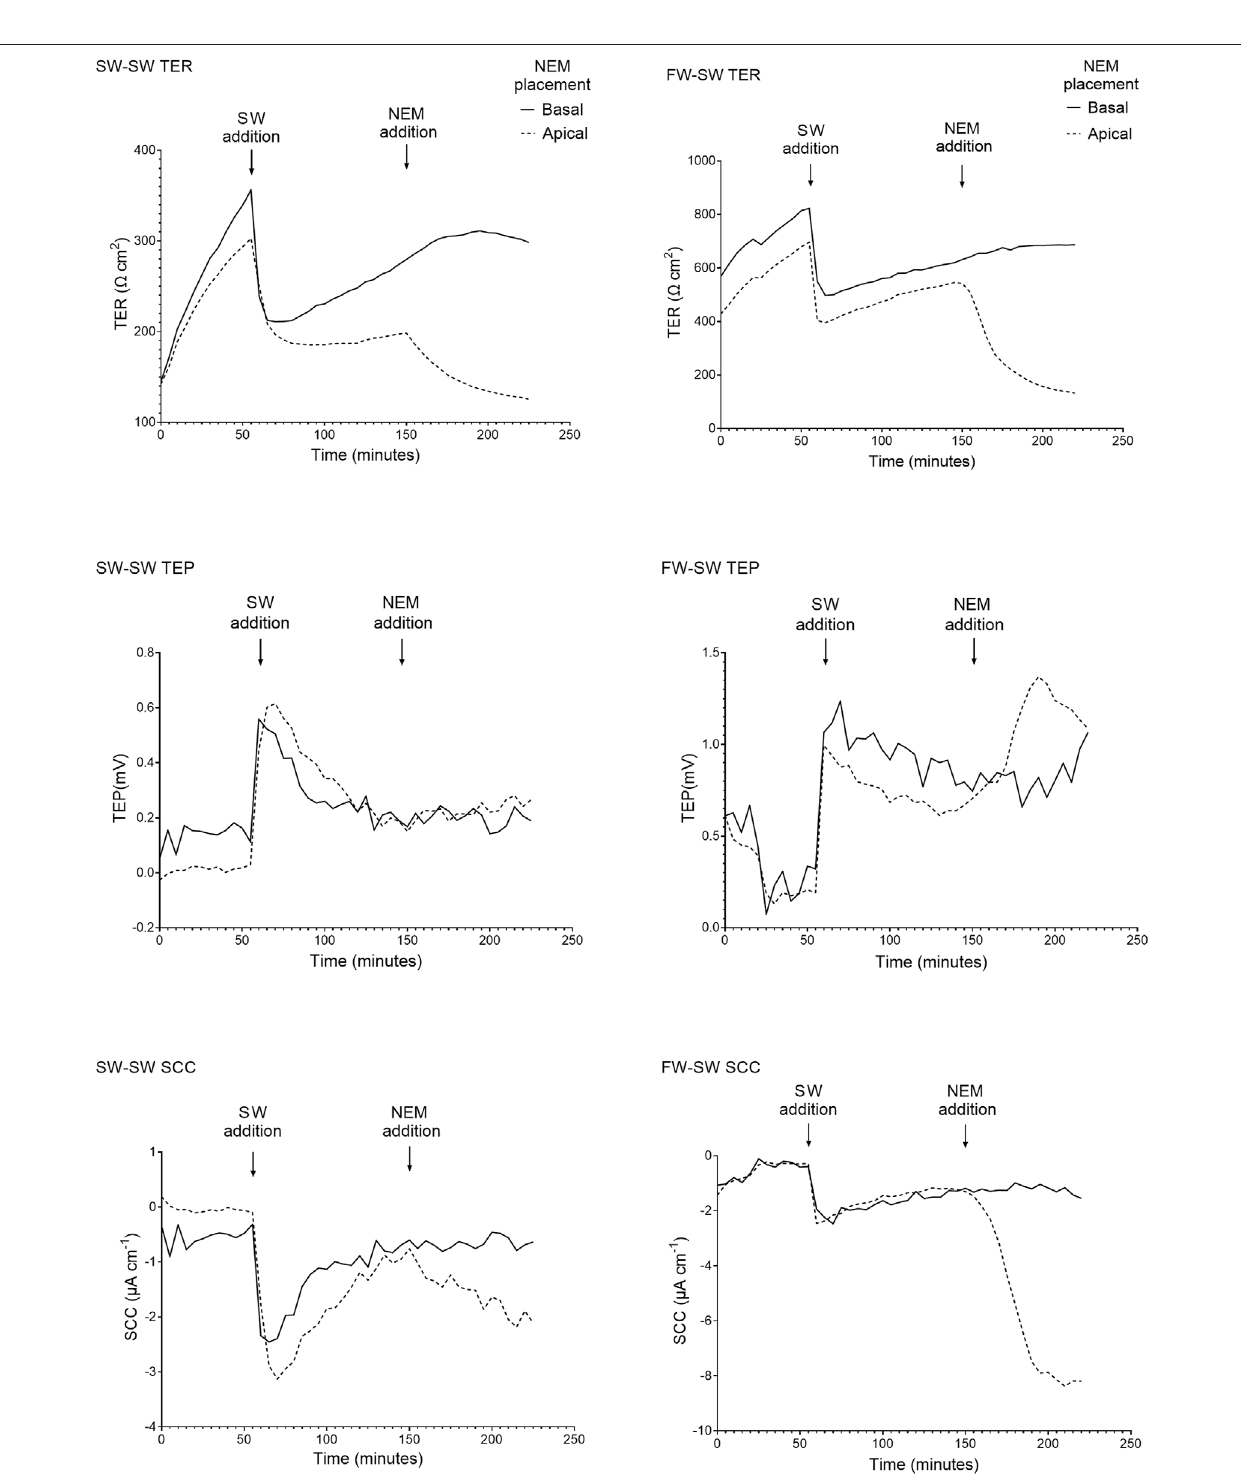
FIGURE 5 | Representative traces of the electrical parameters transepithelial resistance (TER), transepithelial potential (TEP), and short circuit current (SCC) time series of fi sh exposed to SW (SW-SW and FW-SW) in the apical chamber half. A large and acute reduction in TER is shown following SW addition, accompanied by an acute change in TEP (basal-positive). The addition of NEM is also shown, with a reduction in TER and a change in TEP (basal-positive). Again, the changes in TEP and SCC following NEM addition are far more pronounced in the FW acclimated group.